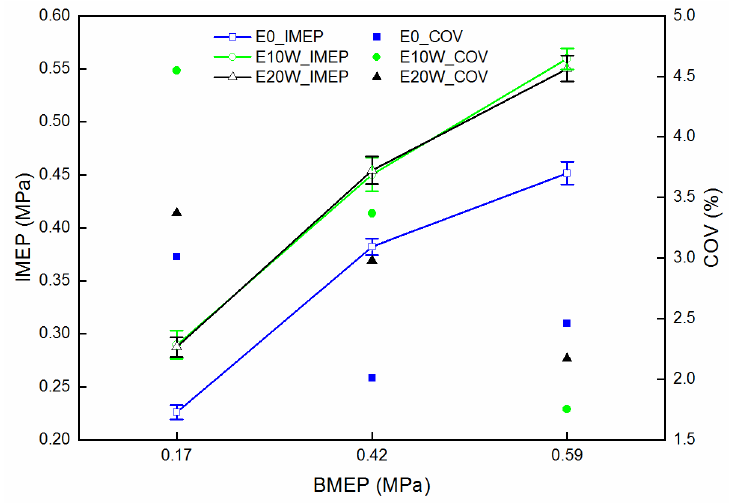
Figure 6. The cycle-by-cycle variations in IMEP for E0, E10W and E20W under three various